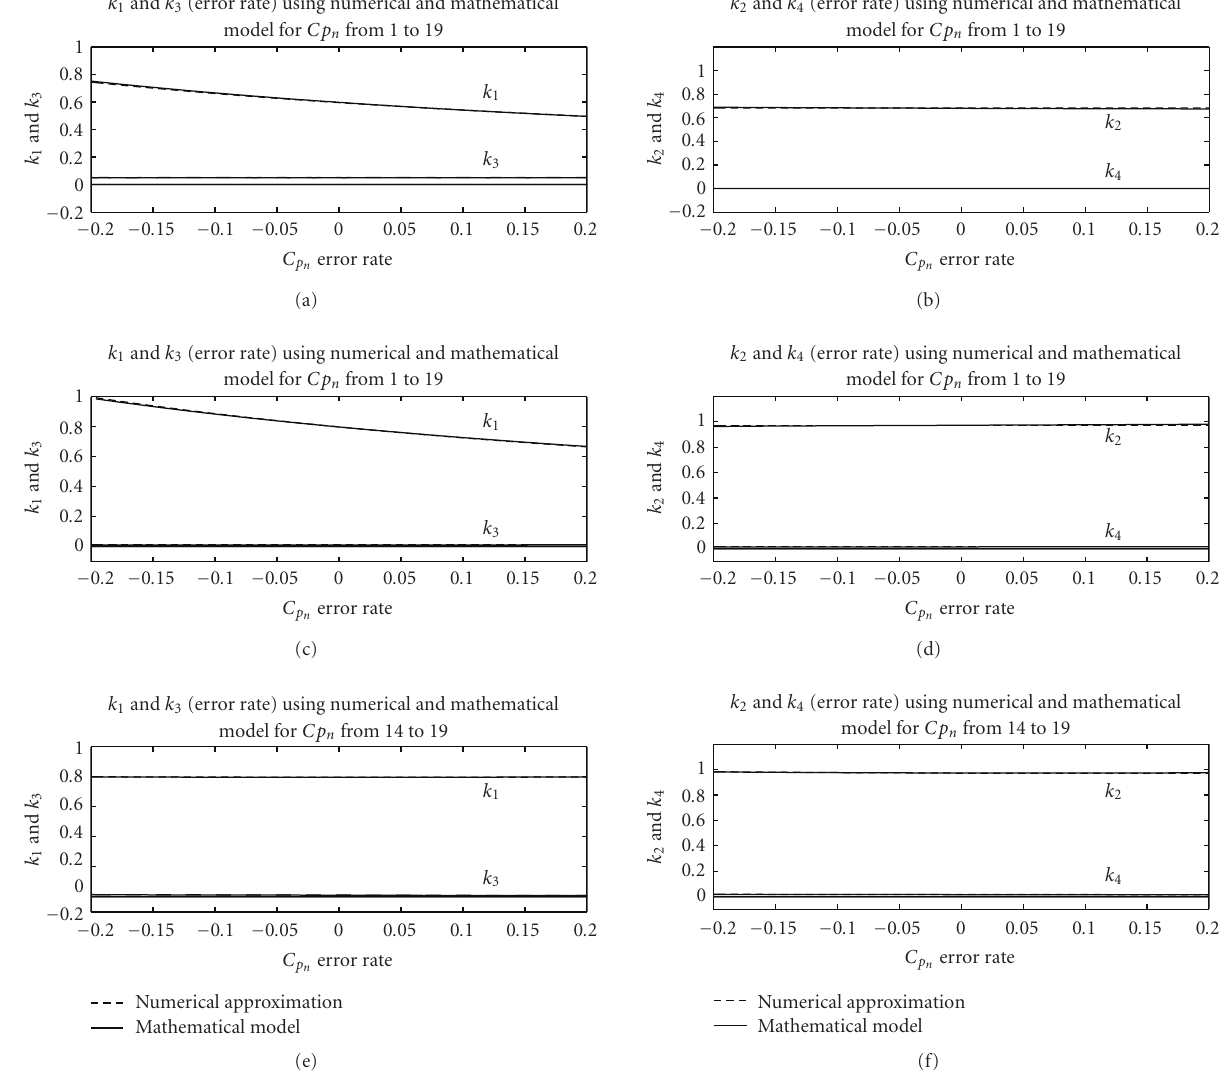
Figure 7: Comparison between the estimated k 1 , k 2 , k 3 , and k 4 of tumor using the derived expressions and numerical approximation for a range of erroneous blood functions. Top two figures show results when all samples of the blood are erroneous, middle two when the initial peak is erroneous, and the bottom two when the tail part is